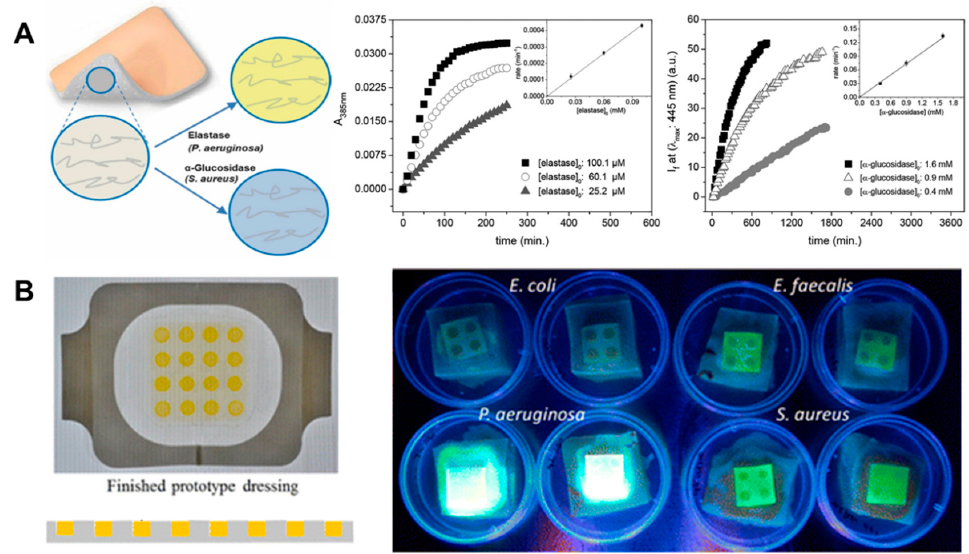
Figure 6 . Hydrogels for in situ fluorogenic and chromogenic detection of a bacterial infection. ( A ) Chitosan hydrogel films carrying fluorogenic and chromogenic substrate for simultaneous identification of Pseudomonas aeruginosa and Staphylococcus aureus through their characteristic enzyme